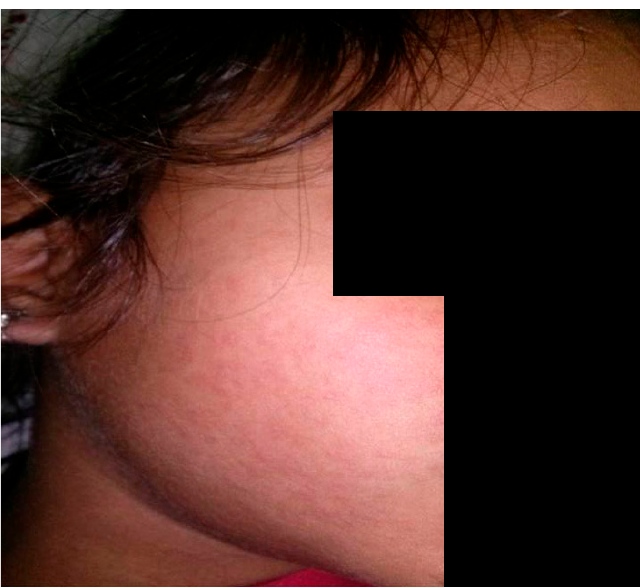
Figure 2. Viral exanthem on face of child.